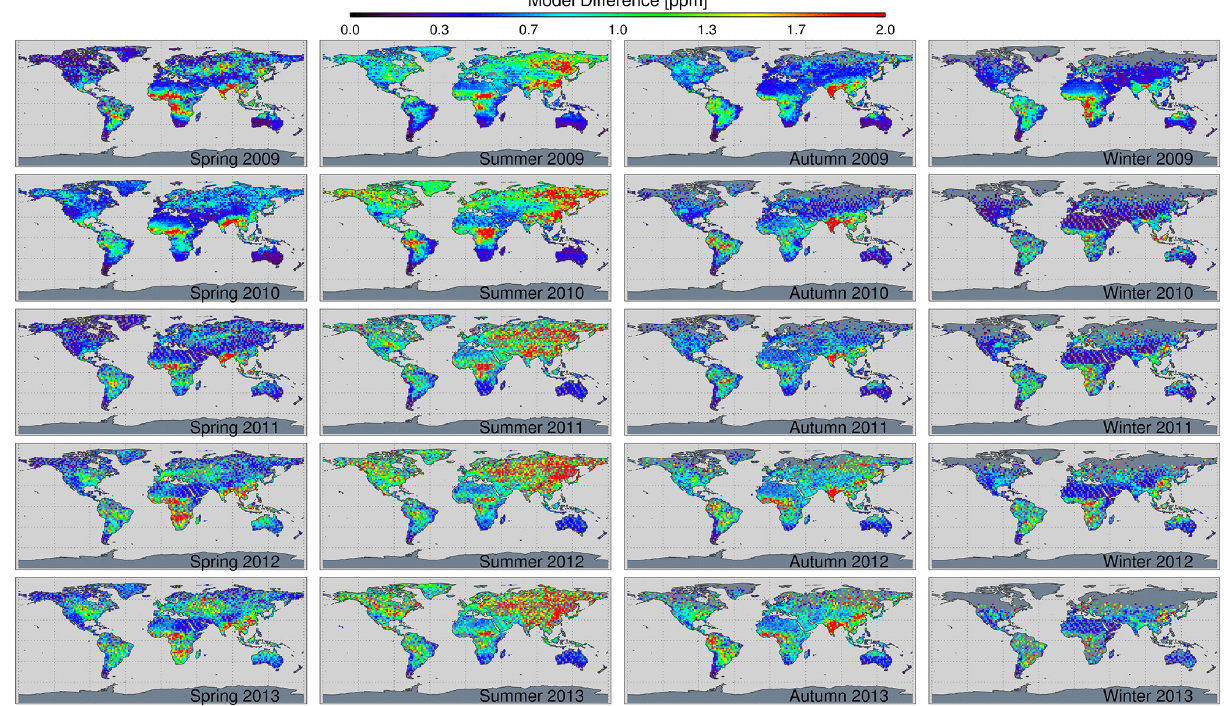
Figure 5. Seasonal maps of the model difference, defined as the maximum absolute difference of the three-model ensemble from the median. All individual soundings have been averaged into 2 ◦ × 2 ◦ grid boxes over each season. The largest uncertainties occur in regions where the CO 2 variability is expected to be highest and the models are unconstrained by surface measurements.